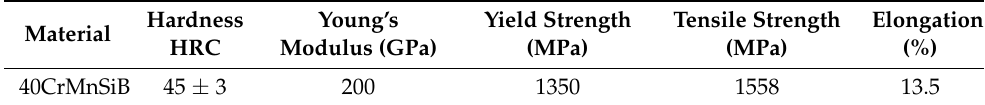
Table 1. The mechanical properties of 40CrMnSiB steel.